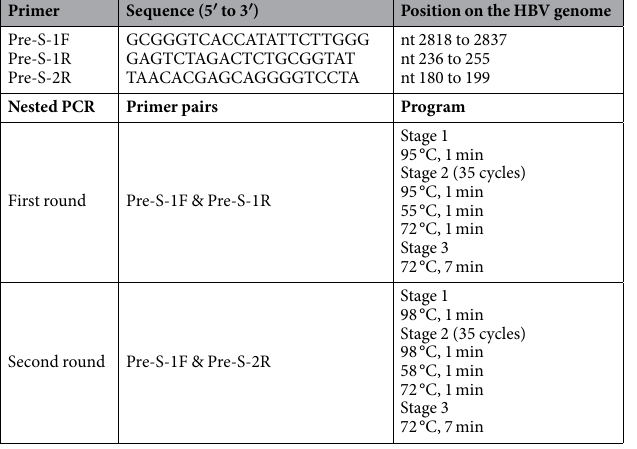
Table 4. The primers and program of nested PCR for amplification of HBV pre-S gene. Abbreviations: nt, nucleotide.